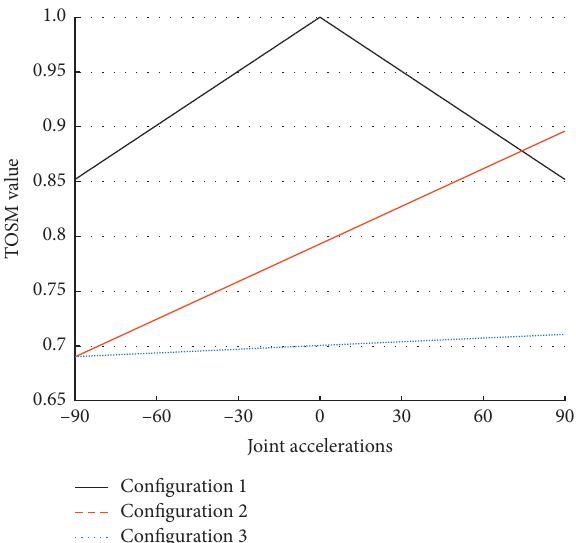
Figure 9: Variation of TOSM with joint acceleration in different configurations.